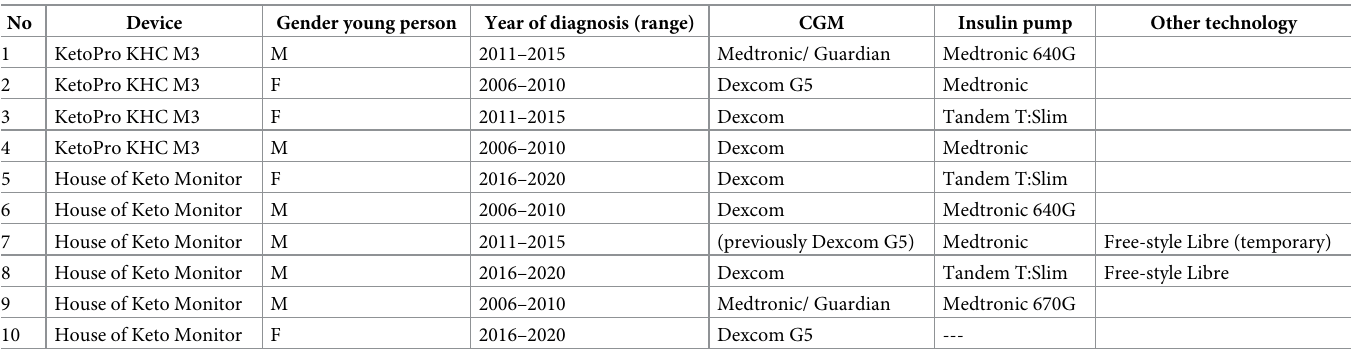
Table 3. Participant characteristics and devices